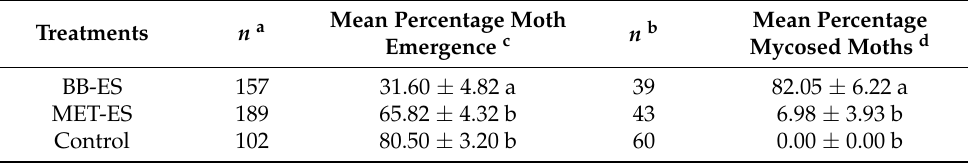
Table 5. Mean percentage moth emergence and mycosis after six-day-old Tuta absoluta pupae were treated with EPF